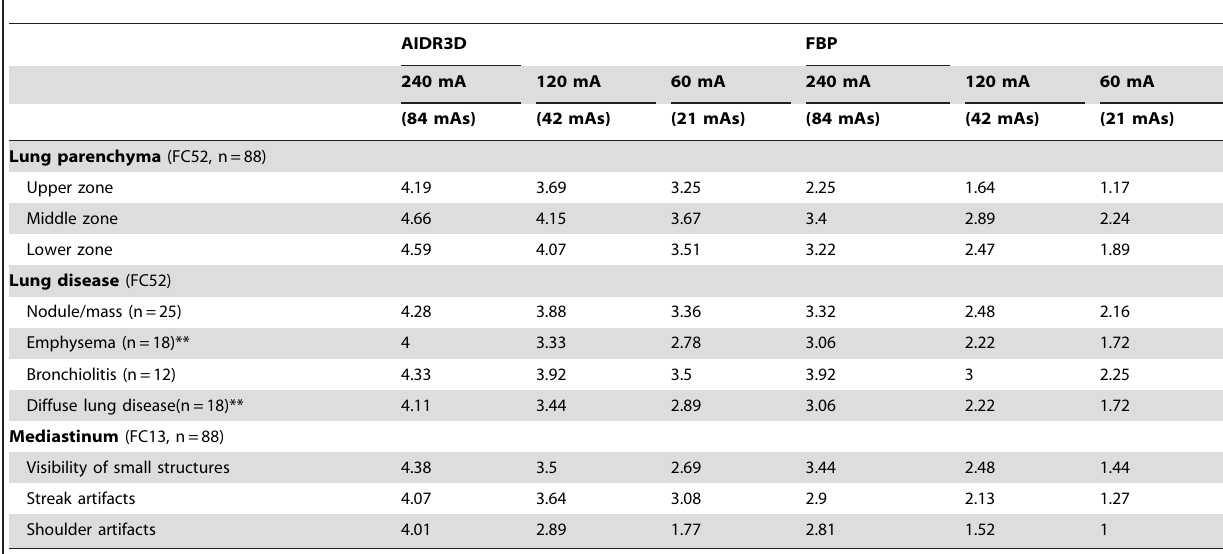
Table 2. Results of qualitative scores* for image quality at different tube currents with AIDR3D and FBP (without AIDR3D).